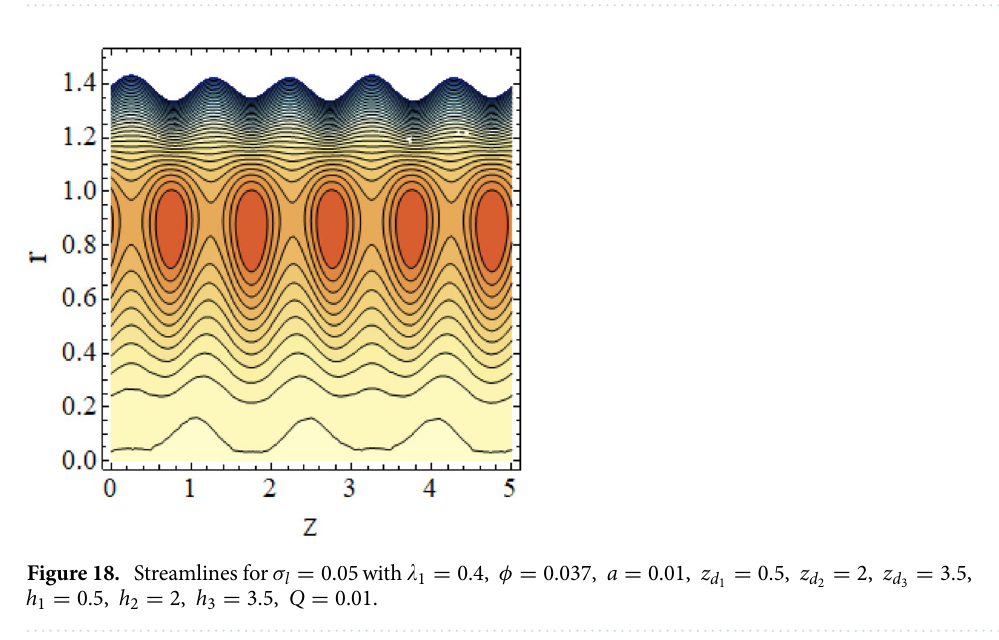
Figure 17. Streamlines for σ l = 0.03 with (cid:31) 1 = 0.4, φ = 0.037, a = 0.01, z d 1 = 0.5, z d 2 = 2, z d 3 = 3.5, h